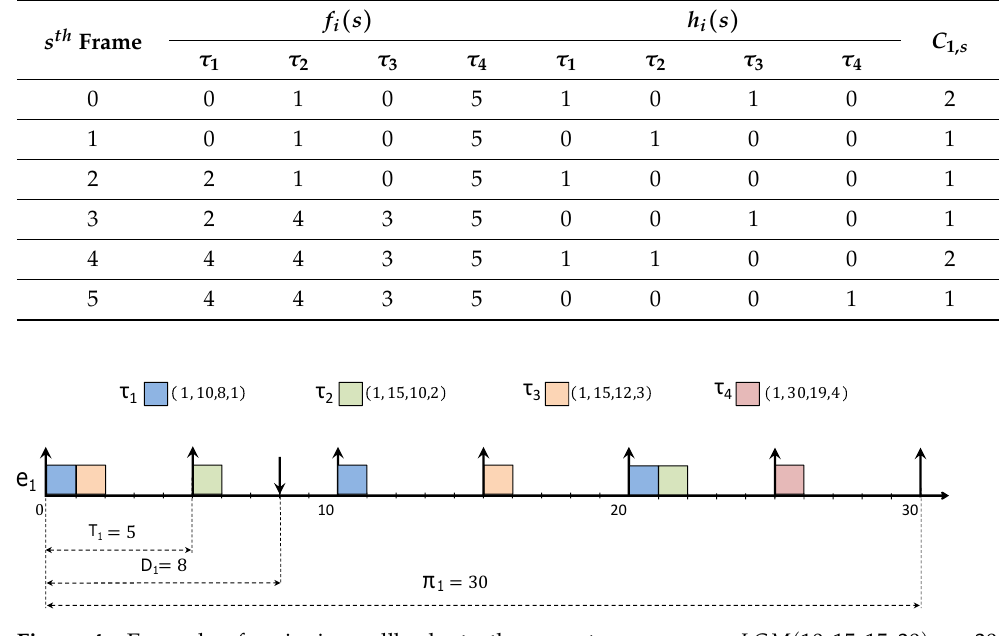
Figure 4. Example of assigning callbacks to the executor e 1 . π 1 = LCM ( 10,15,15,30 ) = 30. T 1 = GCD ( 10,15,15,30 ) = 5. D 1 = min { 8,10,12,19 } = 8. Number of frames N = 30/5 =